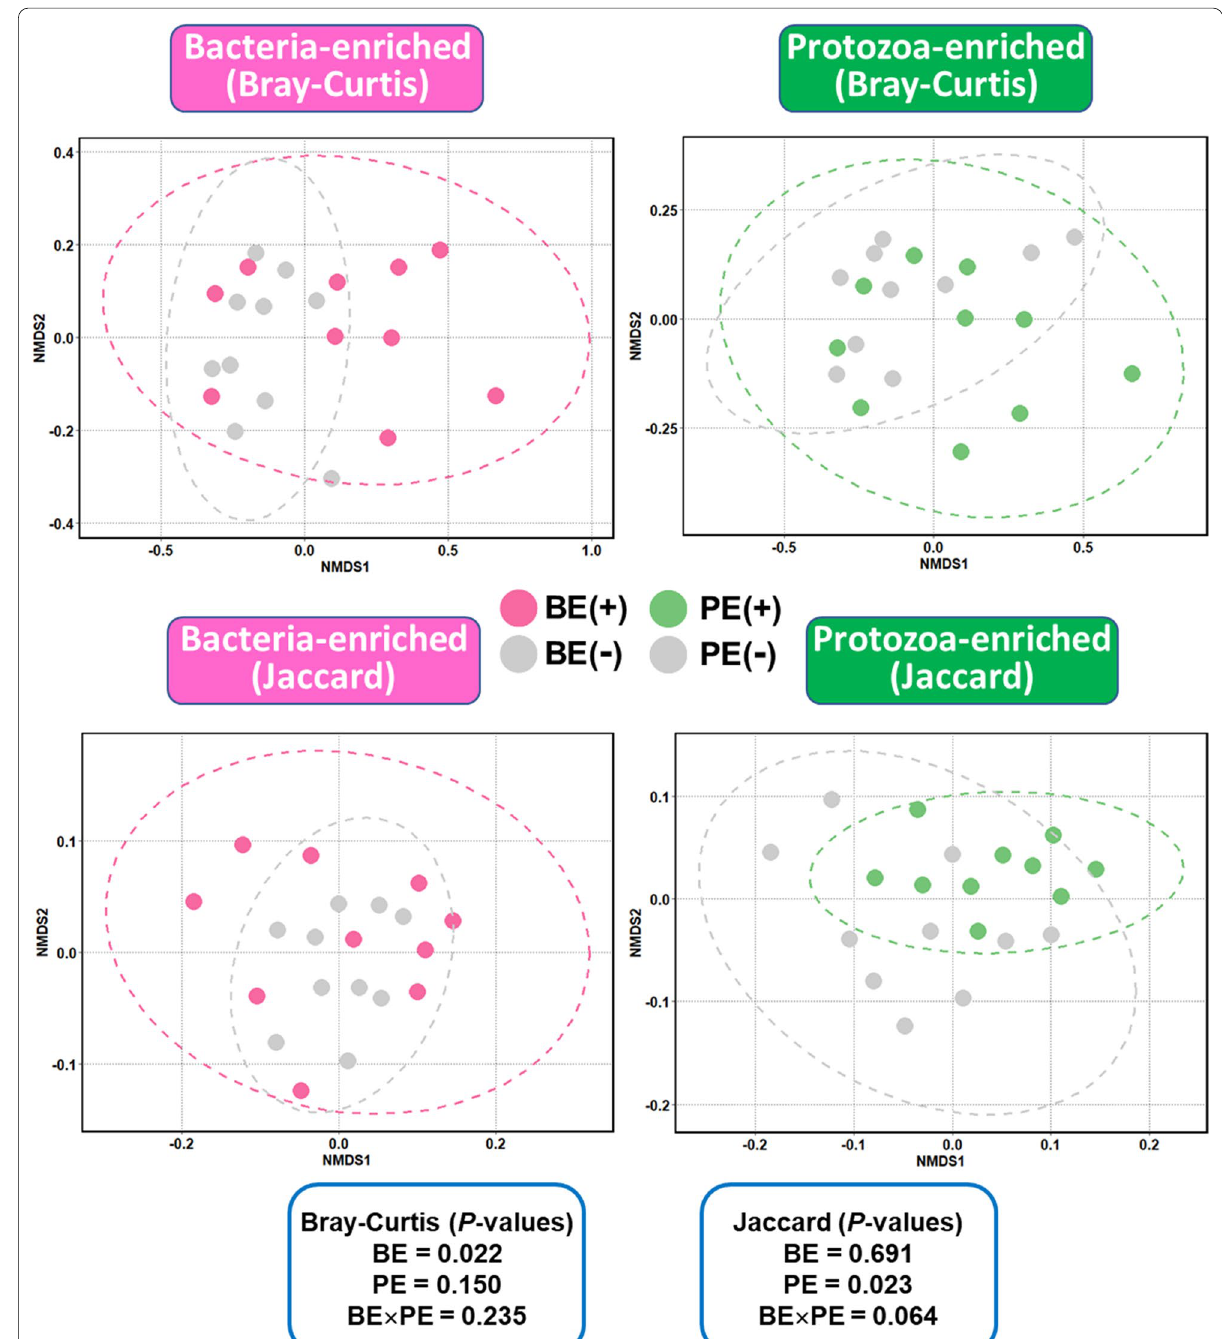
Fig. 3 NMDS plot based on Bray–Curtis and Jaccard distance matrices showing overall microbial functional distribution represented by the relative abundance of annotated KEGG modules in the liquid fraction of dairy calves differed by microbial inoculations with two types of inocula (BE and PE). BE, bacterial-enriched rumen fluid; PE, protozoal-enriched rumen